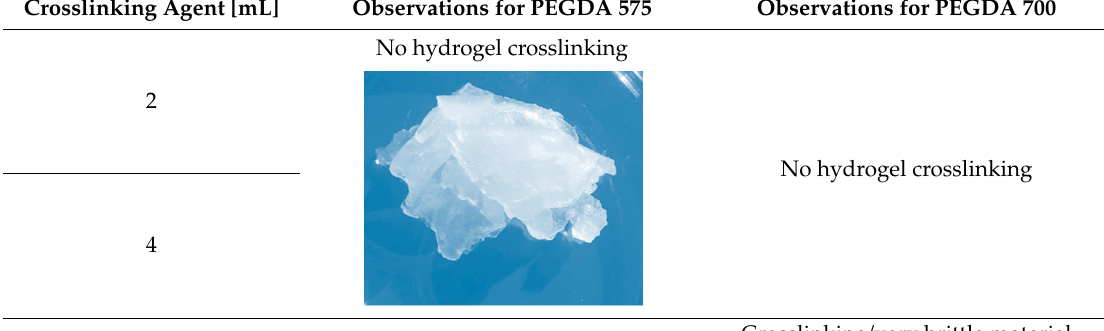
Table 4. Observation of the course of crosslinking process of hydrogels obtained using crosslinkers with different molecular weights and amounts.